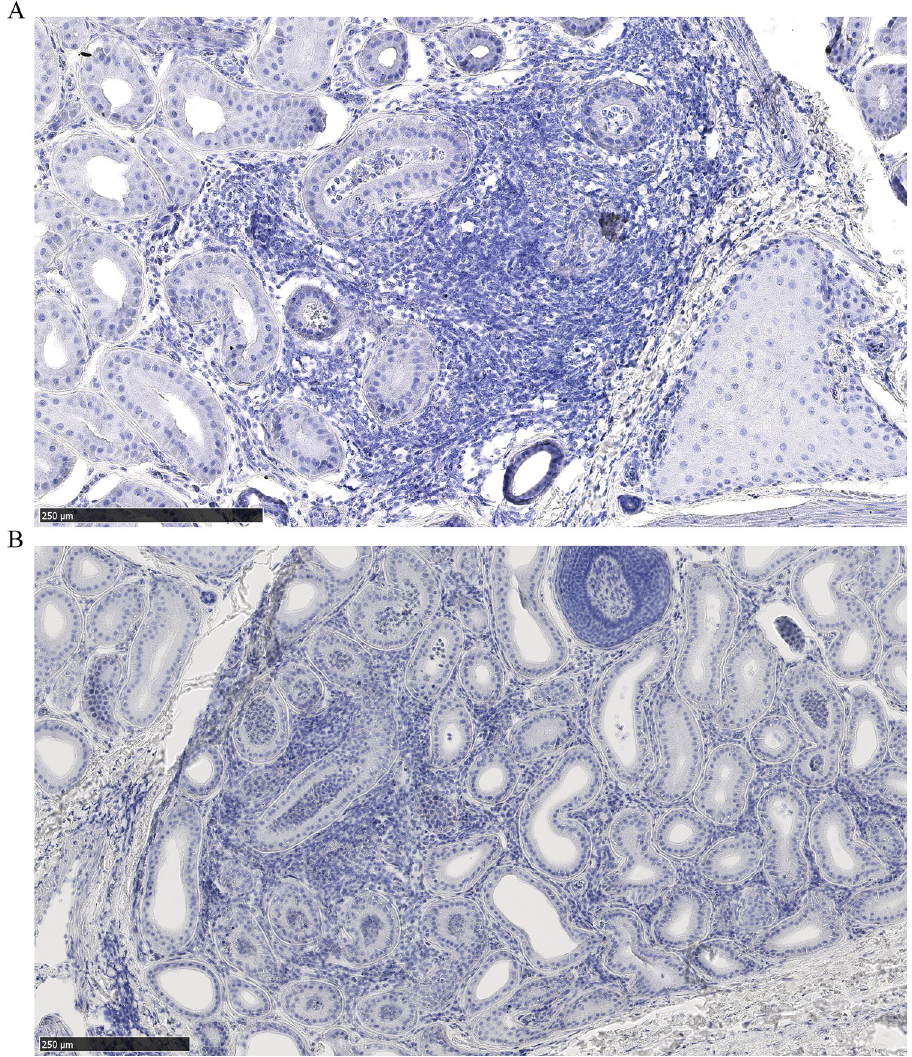
Fig 5. Leukocytic infiltration of sudoriferous gland lumen. (A) Female mule deer hind leg interdigital glands of with PrP CWD deposits in other regions of the section, and (B) an uninfected male mule deer.